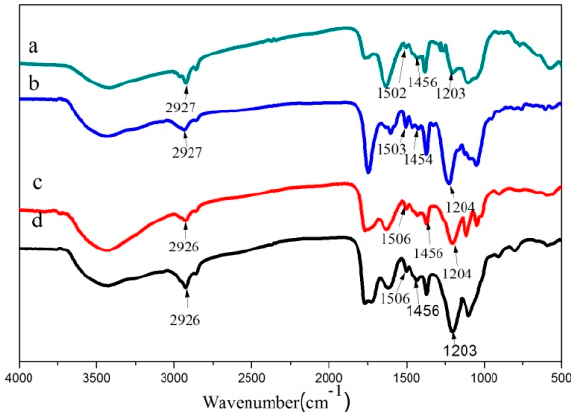
Figure 6. FTIR spectra of WSAL prepared for 7 h ( a ), 5 h ( b ), 3 h ( c ), and 2 h ( d ) with 12:1 molar ratio of ICH to lignin with 4 mL DMF at 145 °C under nitrogen atmosphere.